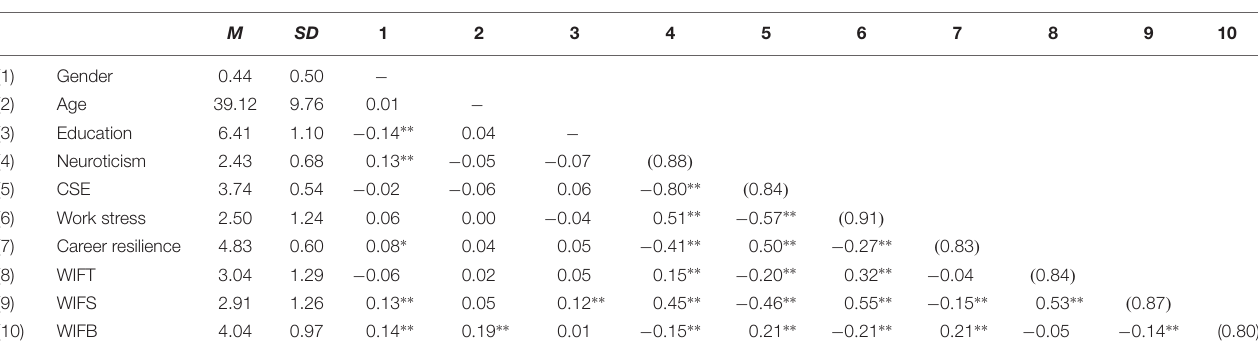
TABLE 1 | Descriptive statistics for study